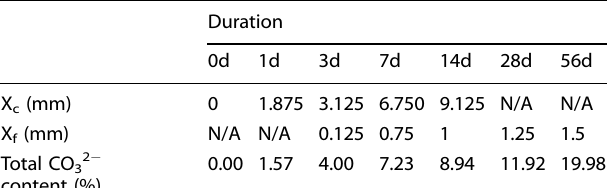
Table 1. Results obtained from Fig. 4, including depth of the carbonation front (X c ), depth of the fully carbonated zone (X f ), and the total CO 32 − content.